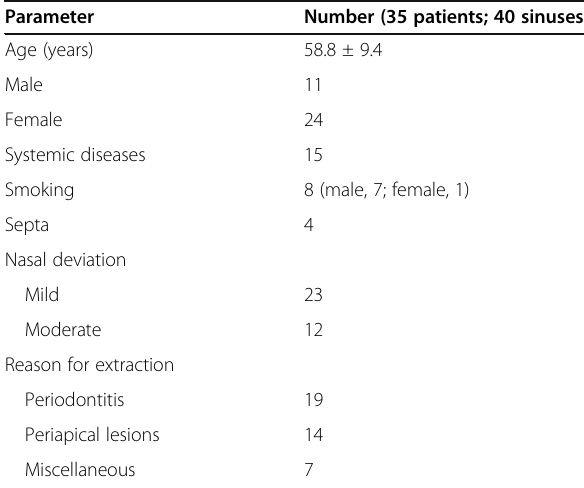
Table 1 Clinical characteristics of patients